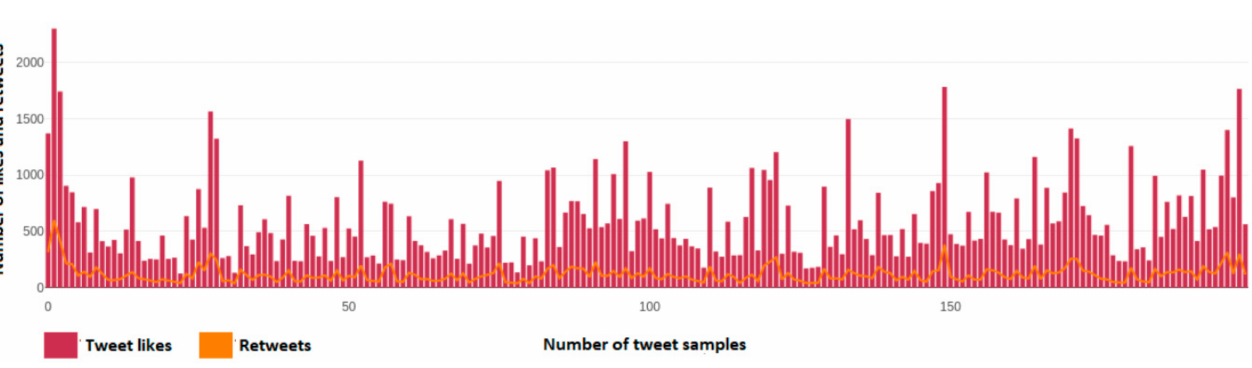
Figure 9. Number of likes and retweets per tweet for @atsipras (200 tweet sample). Figure 10 depicts the number of user reactions, likes, and retweets of each tweet from a dynamic sample of 200 tweets taken from Fofi Gennimata’s (@fofigennimata) account. Axis y depicts the number of likes and retweets that a single tweet has, while the x axis depicts the number of each tweet over this 200-tweet